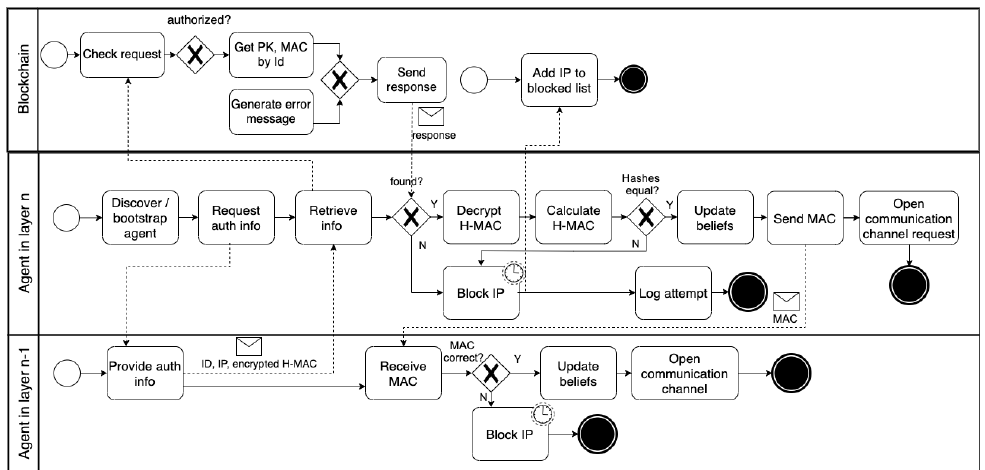
Figure 9. The dynamic authentication process (mitigates fake node